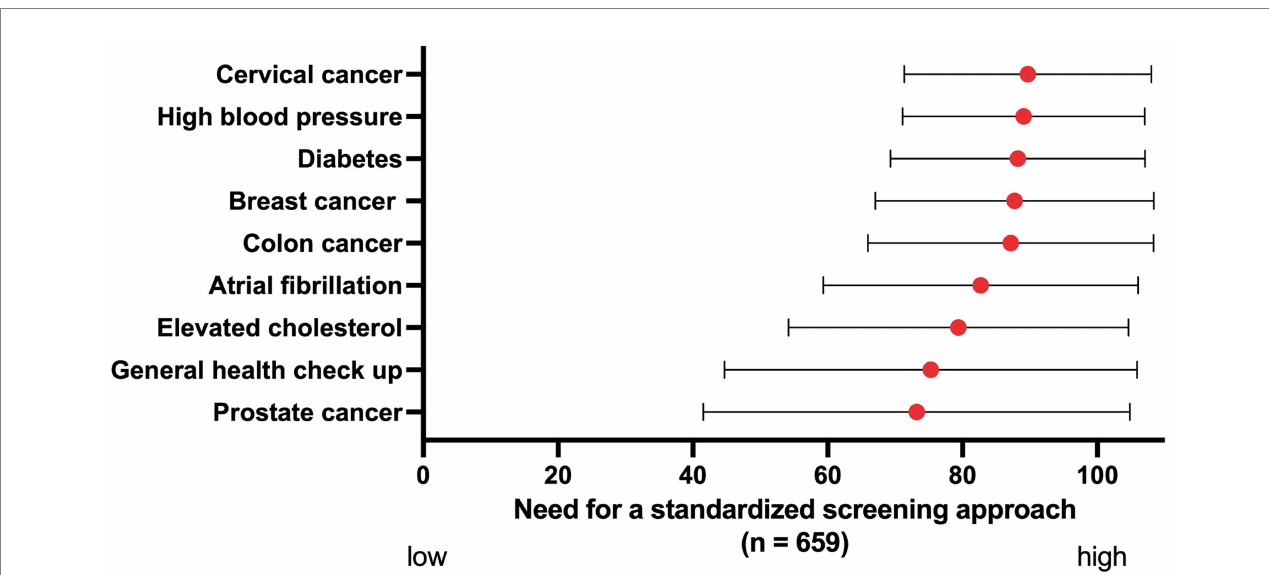
FIGURE 3 The perceived need for a standardized screening approach for different conditions, ranked on a scale from 0 to 100. Red dots: mean. Black bars: standard